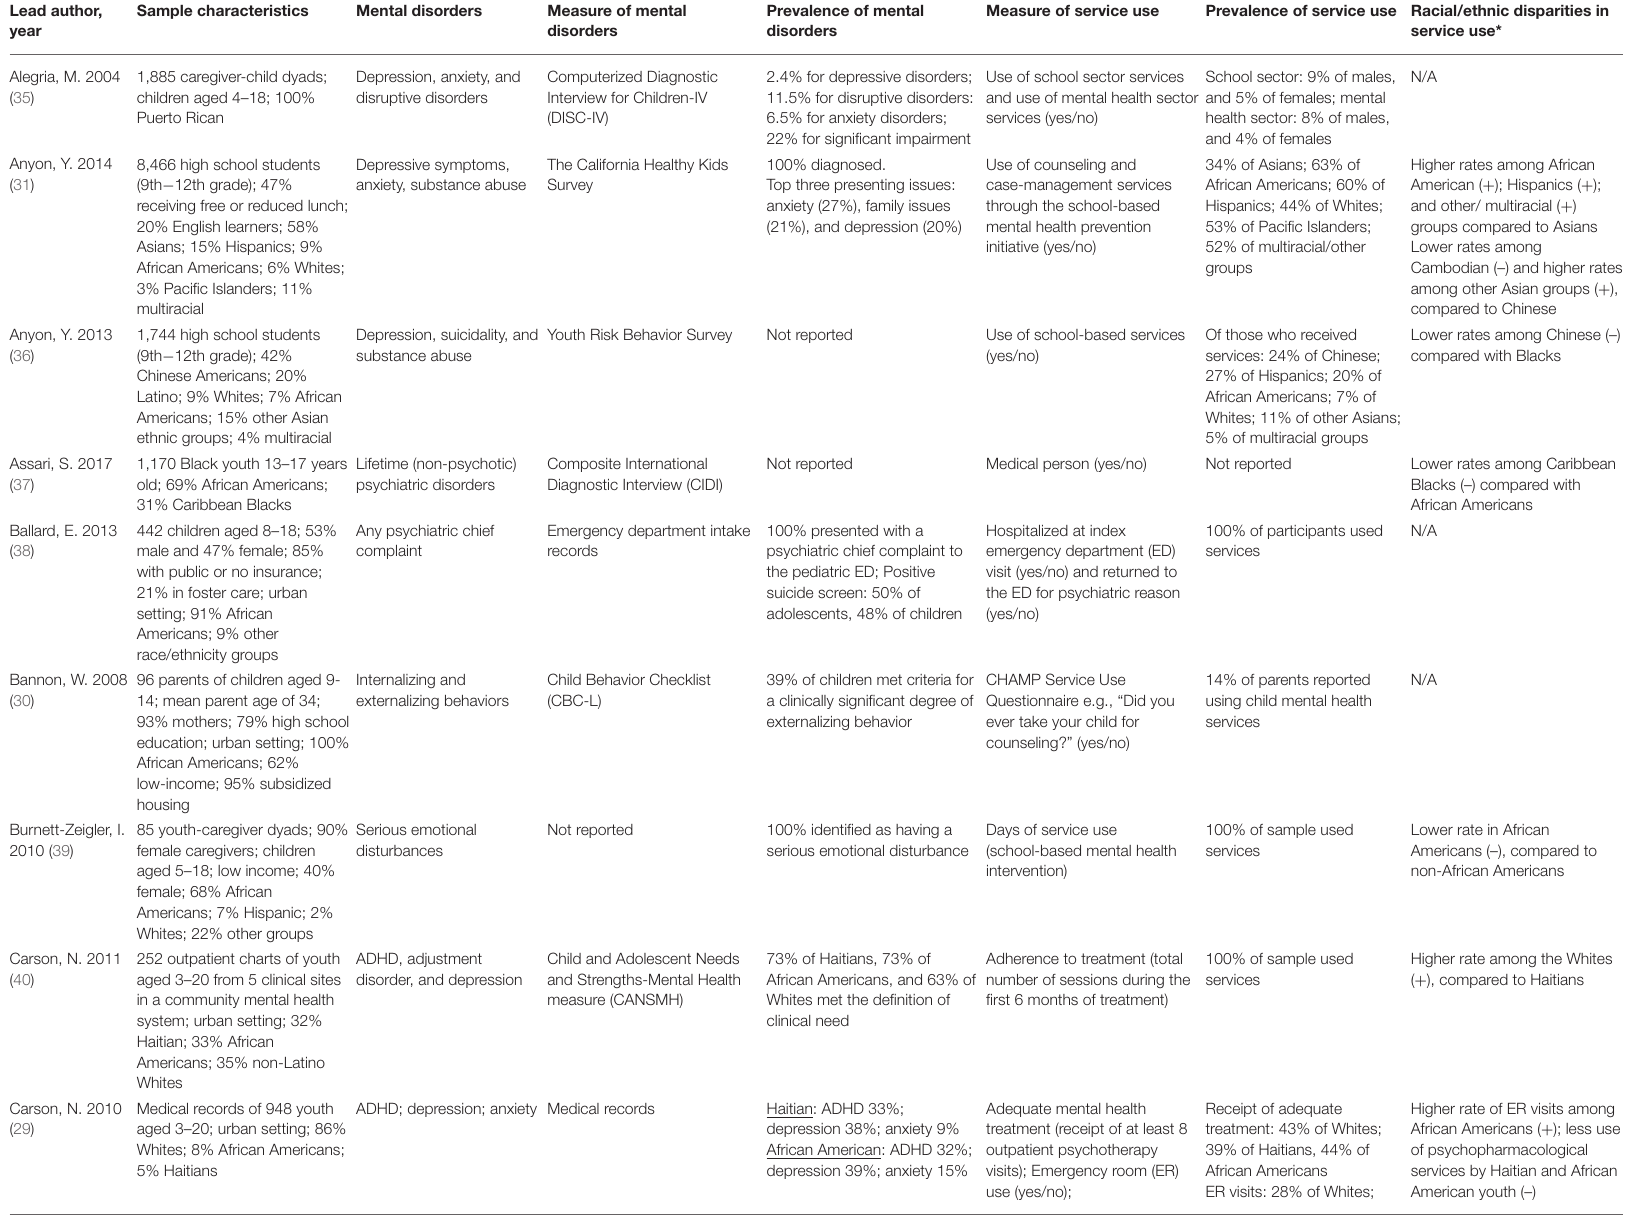
TABLE 2 | Summary of main sample characteristics across the reviewed